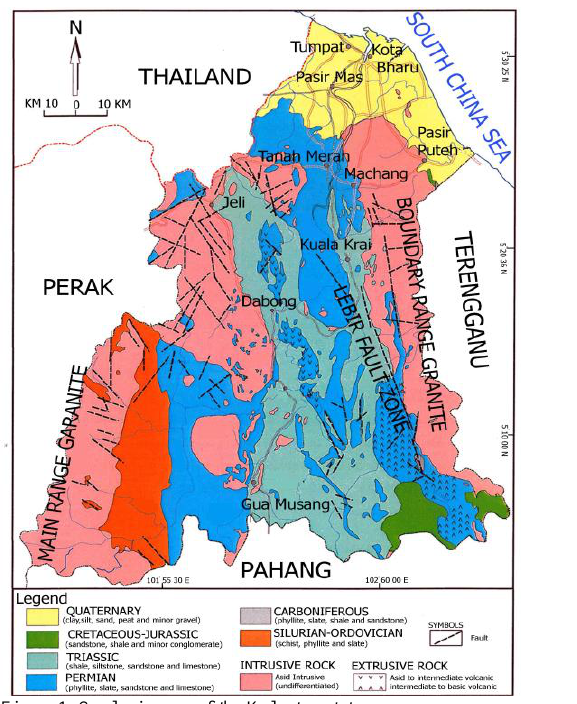
Figure 1. Geologic map of the Kelantan